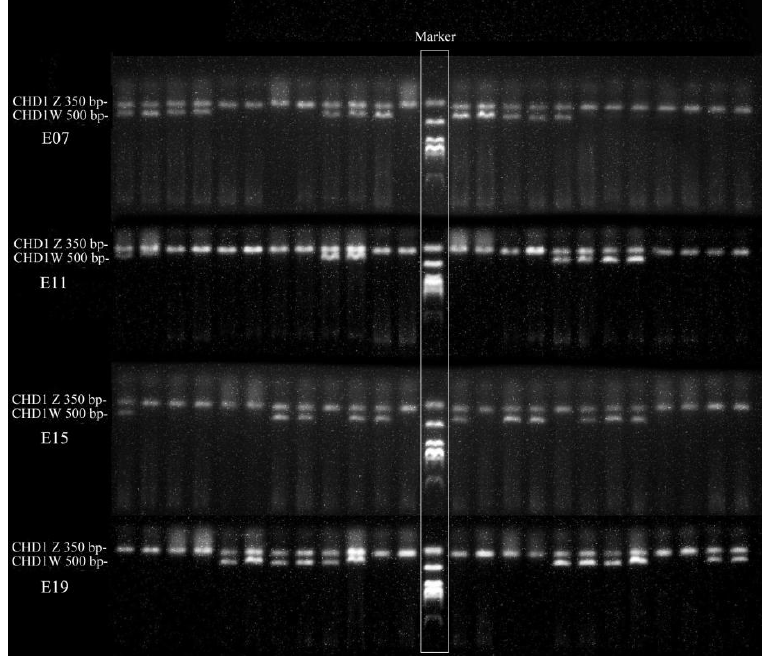
Figure 1. Gel electrophoresis of chicken embryos for sex identification. Two bands in these samples indicate female chicken embryos, while one band means male embryos, and the middle shows the DNA markers.